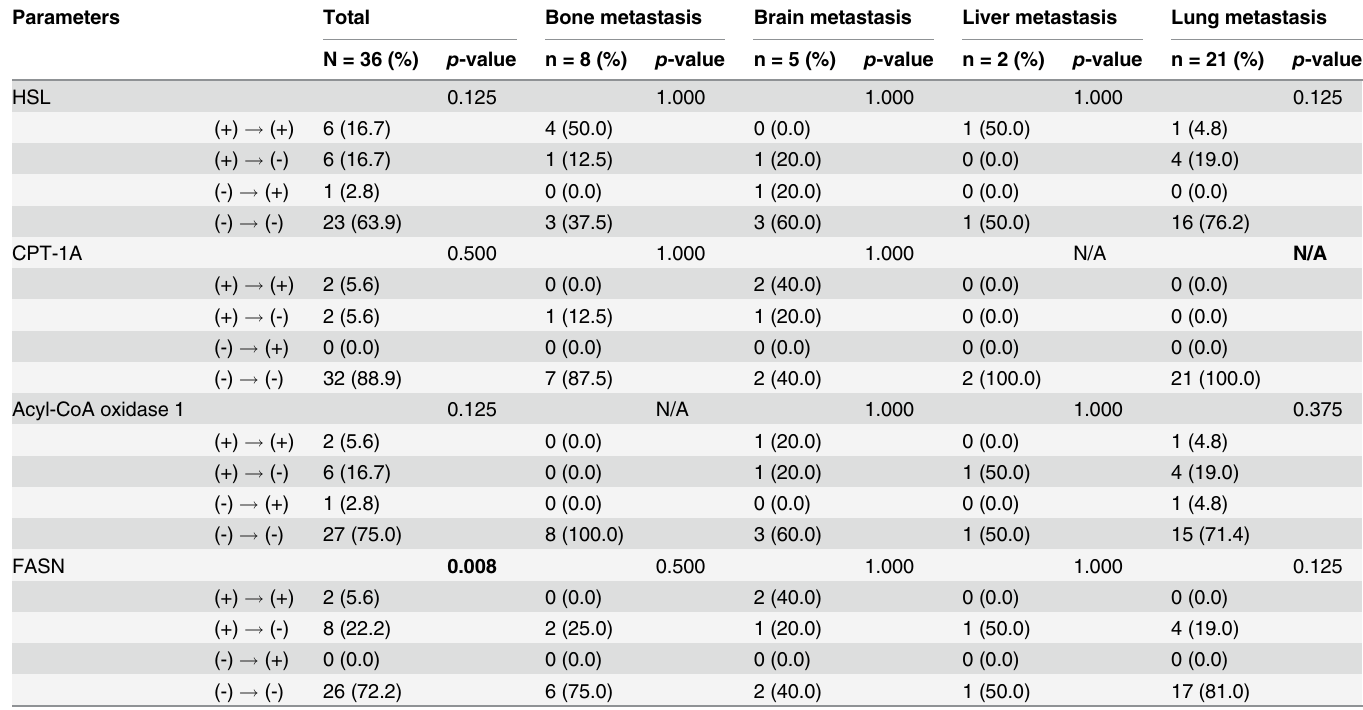
Table 4. Correlation of expression of metabolism-related proteins between primary and metastatic breast cancer according to metastatic site * . Parameters Total Bone